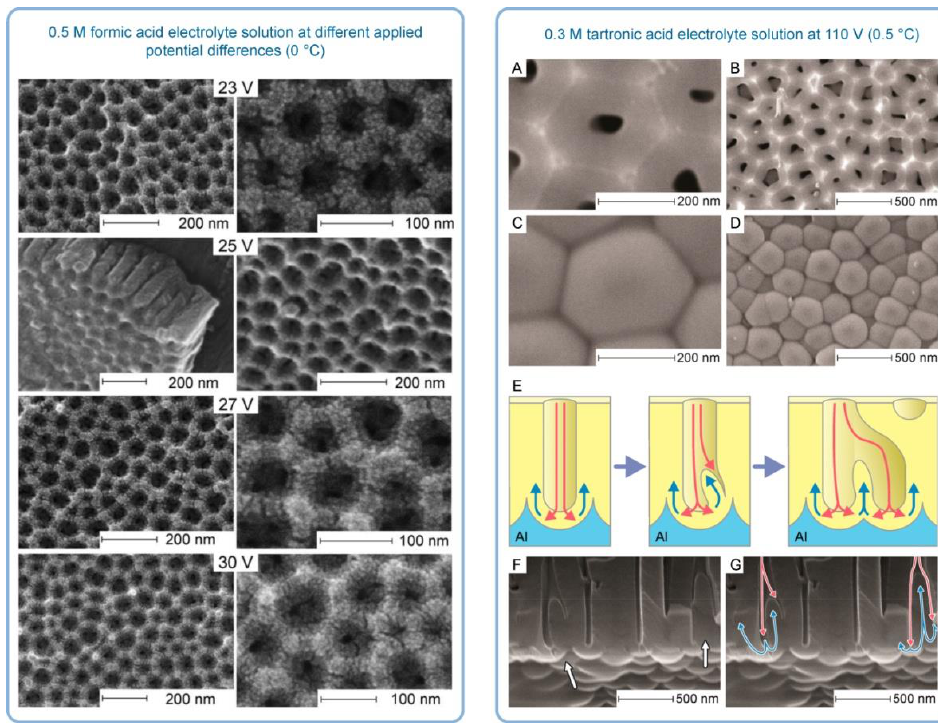
Figure 26. Left: PAA laminas formed in 0.5 M formic acid (HCOOH) solution under different applied voltages at 0 °C. Right: the porous side ( A , B ) and the barrier layer ( C , D ) of unsupported PAA laminas obtained from 0.3 M tartronic acid (HOOC−CH(OH)−COOH) solution at 110 V; schematic representation ( E ) and experimental observation in SEM ( F , G ) of meander-shaped protuberances leading to pore branching. The emergence of such protuberances and the formation of satellite channels is caused by the change from laminar to transitional flow mode upon small flow perturbations. Adapted with permissions from [16] and [62]. Copyright 2011 The Royal Society of Chemistry and 2017 American Chemical Society.